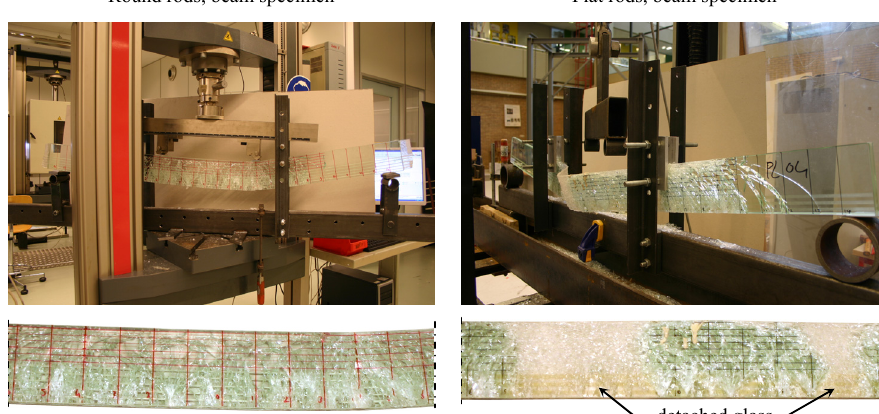
Figure 6: Tested beam specimen with round rods (left) and flat rods